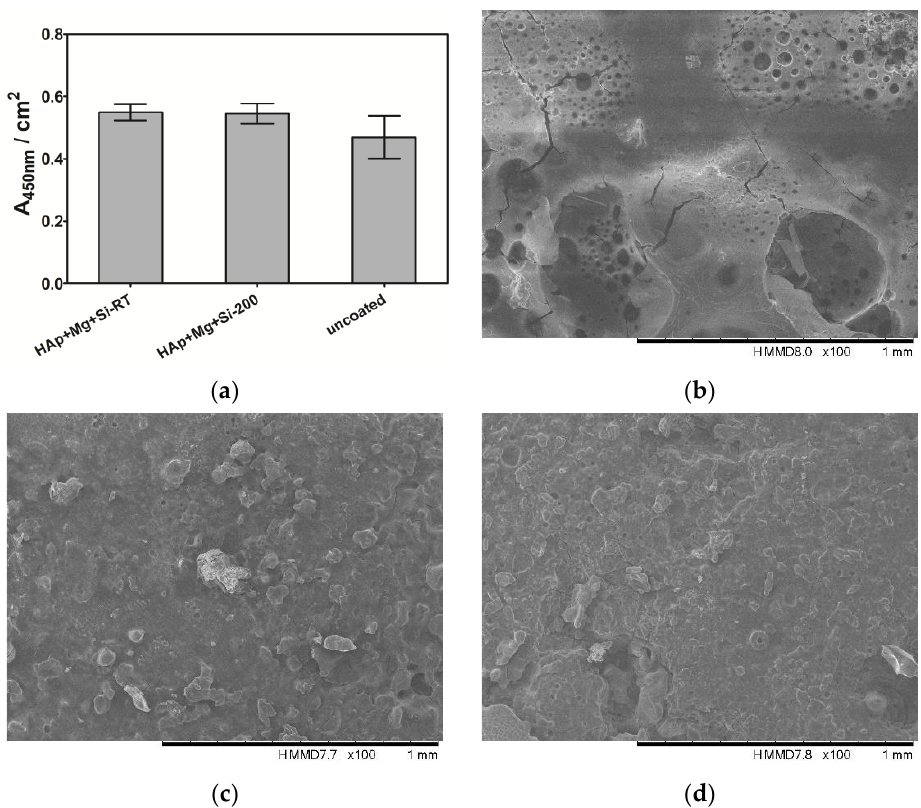
Figure 10. ( a ) Surface binding of the mussel-derived peptide to coated AZ31B. Samples were glued into wells of a 12-well plate prior to coating. Surface binding to uncoated AZ31B served as a control. Data are shown as mean ± standard error of the mean; n = 2. ( b – d ) 2D SEM images of ( b ) no, ( c ) HAp + Mg + Si_RT and ( d ) HAp + Mg + Si_200 coatings deposited on AZ31B prior to coating with 1 µM mussel-derived peptide.